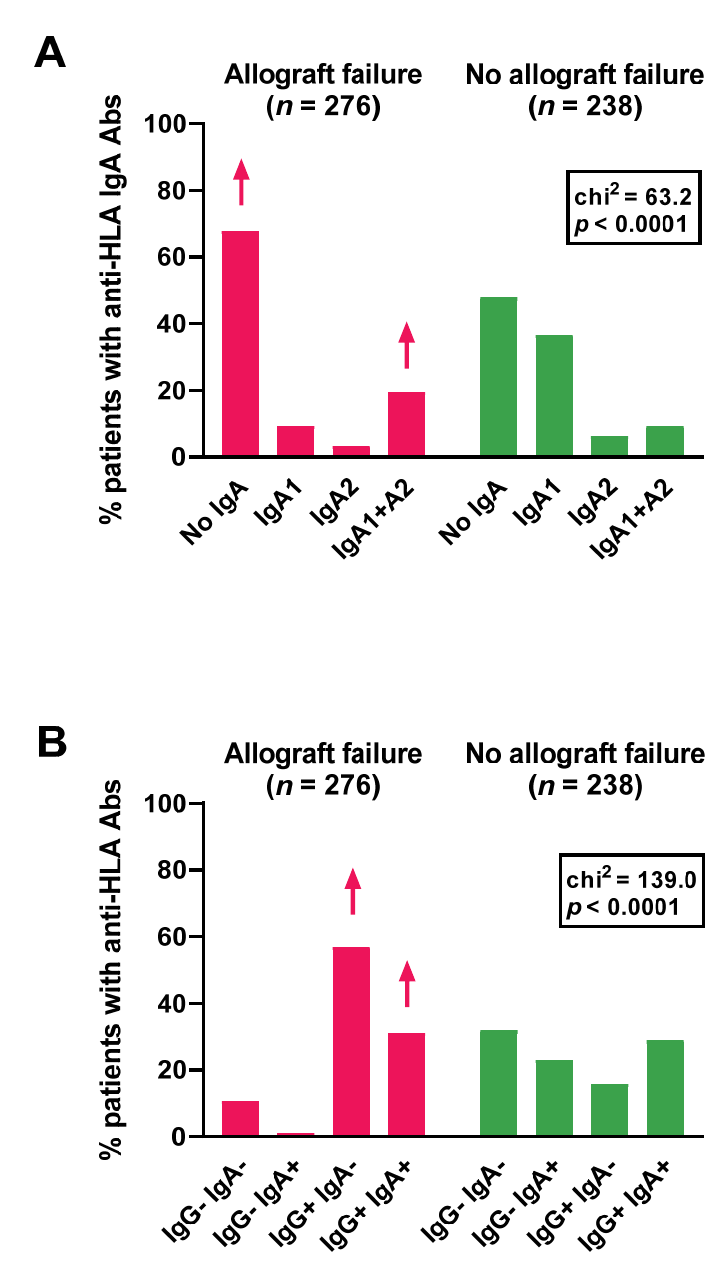
Figure 1. Distribution of anti-HLA IgA and IgG antibodies in kidney transplant recipients with and without allograft failure. This analysis includes 276 patients with allograft failure, which again required dialysis. The control group of 238 kidney transplant recipients still had a functioning graft. Both groups were compared by chi-square test. Panel ( A ) shows data on IgA and its subclasses IgA1 and IgA2, panel ( B ) on IgG and IgA. Abs, antibodies.